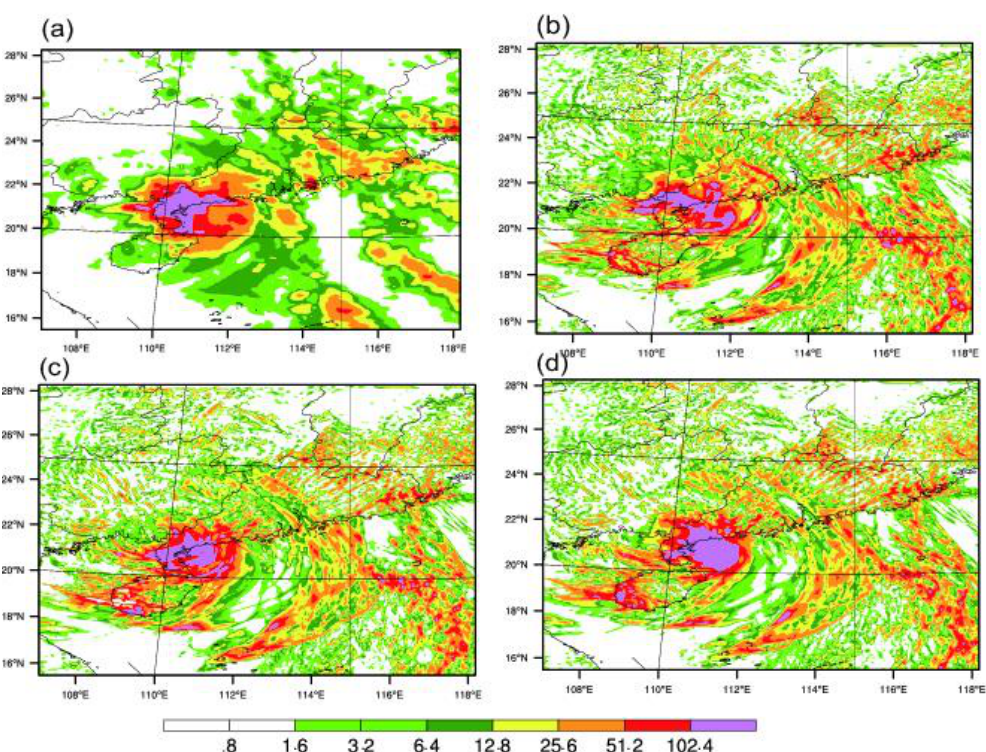
Figure 10. The 12 h accumulated precipitation (mm) according to the ( a ) CMA observations, ( b ) RV_RF_CV7, ( c ) RV_RF_CV8, and ( d ) RV_RRF_CV8 experiments, initialized at 0000 UTC on 22 July 2010.